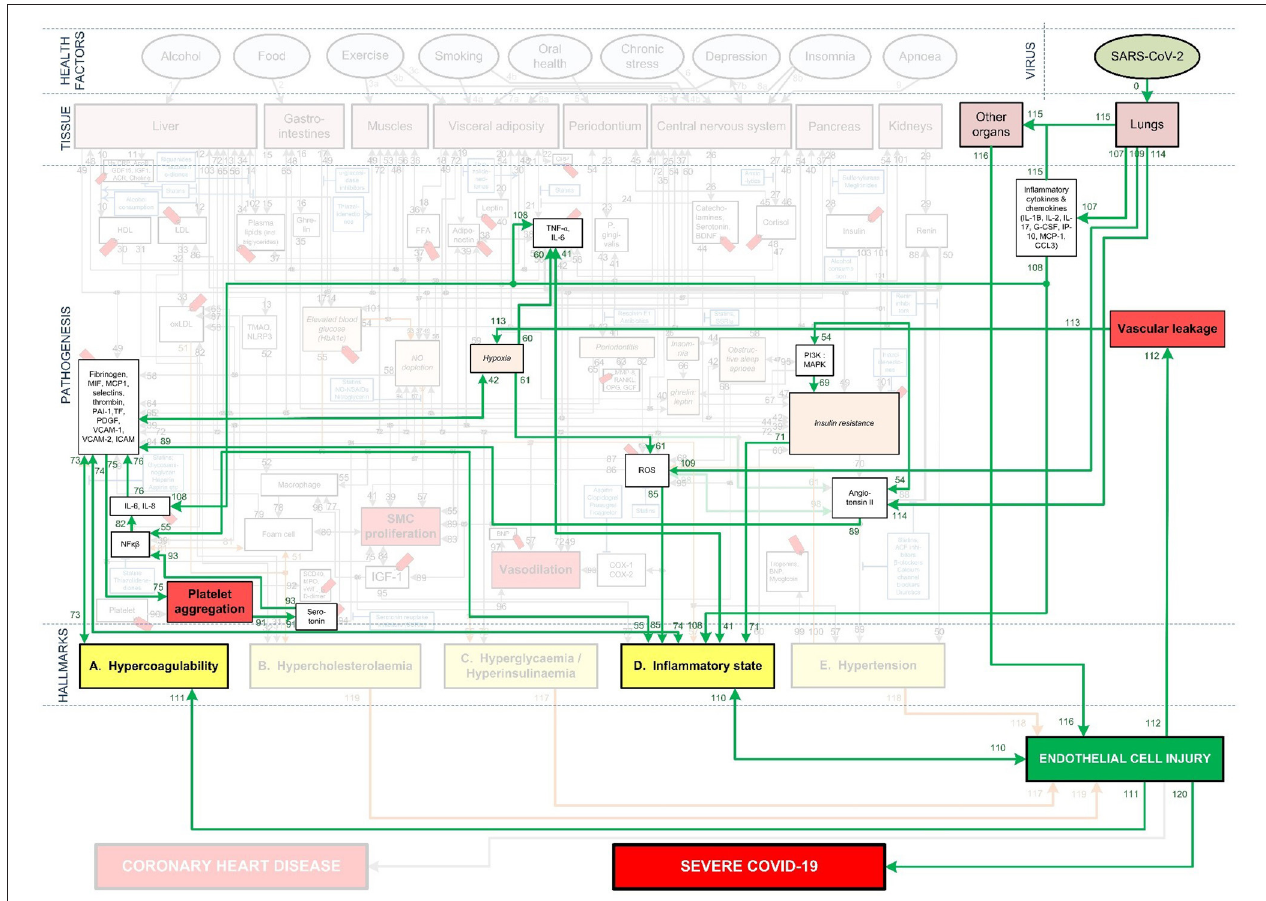
FIGURE 3 | Integration of Covid-19 pathogenic pathways into the pathways of